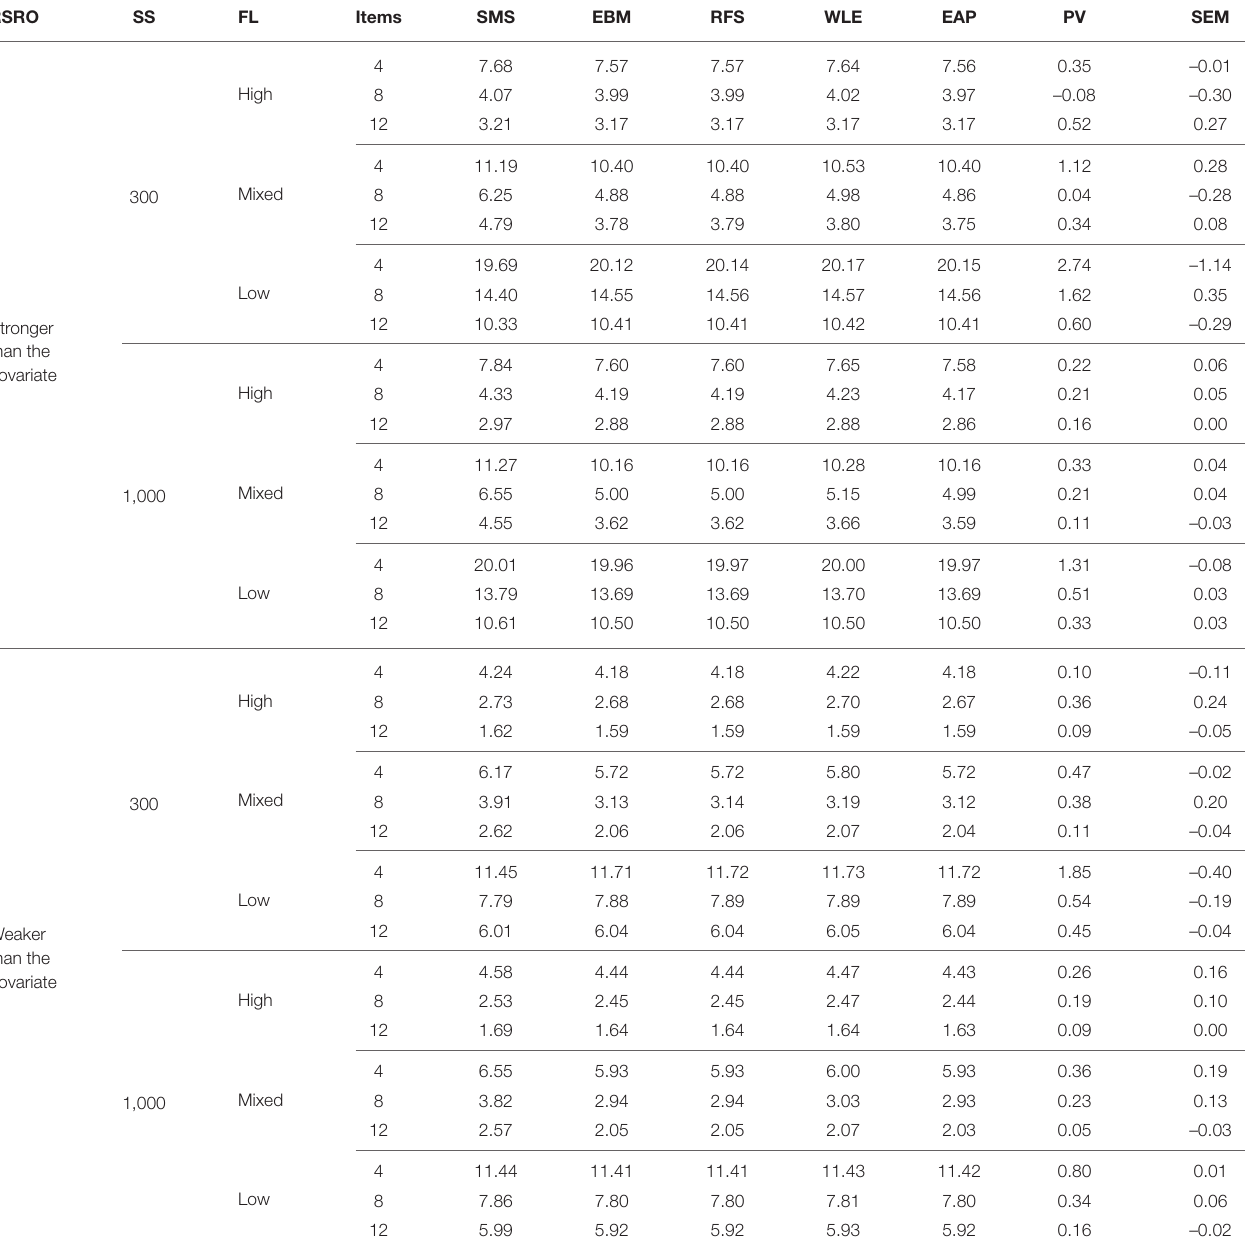
TABLE 7 | Mean percentage bias of regression coefficient of the covariate for different approaches for each condition. RSRO SS FL Items SMS EBM RFS WLE EAP SEM